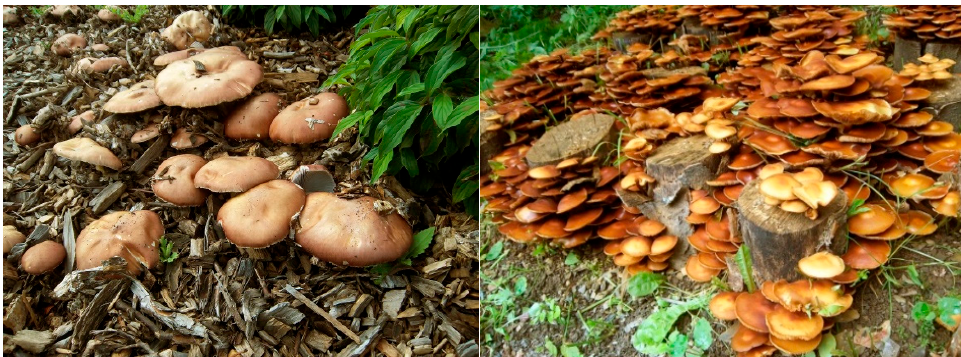
Figure 1. Basidiomes of S. rugoso-annulata ( left ) and K. mutabilis (Strophariaceae) ( right ) .